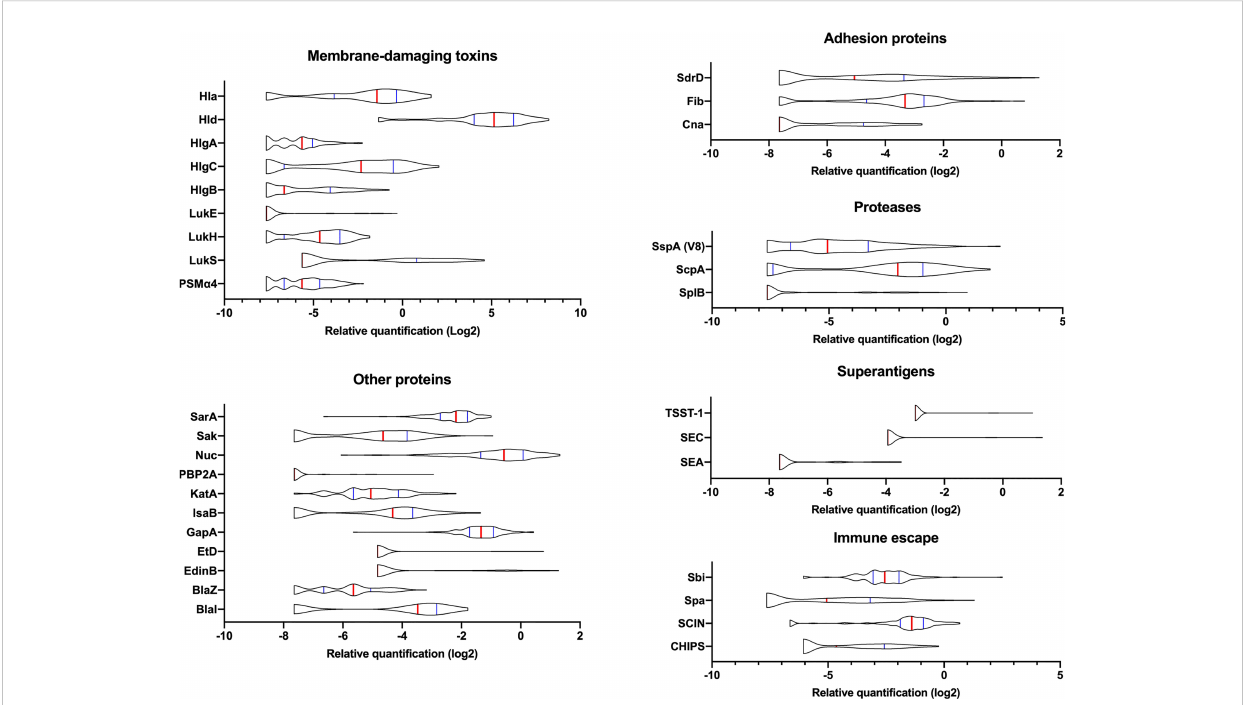
FIGURE 2 Variations in the expression of virulence factors between clinical strains. The relative amount of virulence factors expressed in log2 and categorized into functional groups are represented using violin plots. A total of 136 clinical strains were analyzed. The red vertical lines represent the medians and the blue lines represent the 1 st and 3 rd